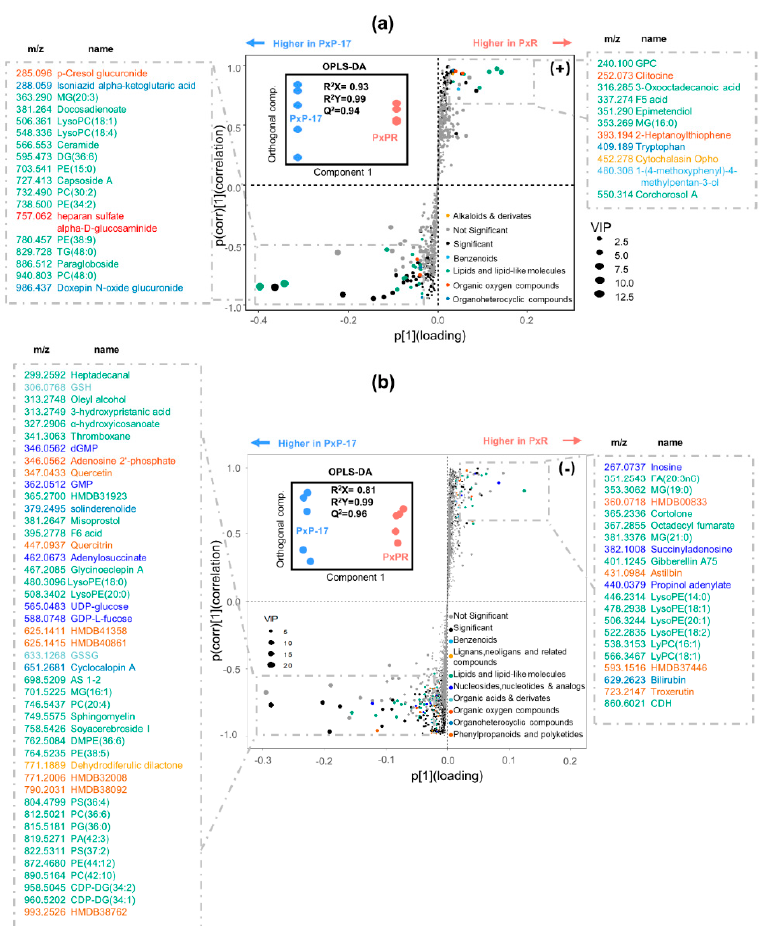
Figure 5. Comparison of metabolites between PxP-17 and PxR. ( a ) Positive mode (+); ( b ) negative mode ( − ). PxR: P. xylostella feeding on radish; PxP-17: the 17th generation of P. xylostella feeding on peas after host shift from radish. The inset box shows orthogonal projections to latent structures discriminant analysis (OPLS-DA) separation between PxP-17 and PxR along with the component that was used for correlating ion intensities. S-Plot obtained from OPLS-DA is shown in the main boxes. Each point represents accurate mass–retention time data. X axis is loadings; Y axis is correlation. Metabolites with absolute value of p (corr) > 0.5 are considered as significantly di ff erent in abundance between PxP-17 and PxR. The m / z [M + H] + of the ions and annotations are shown in the dashed boxes with colors representing compounds from di ff erent